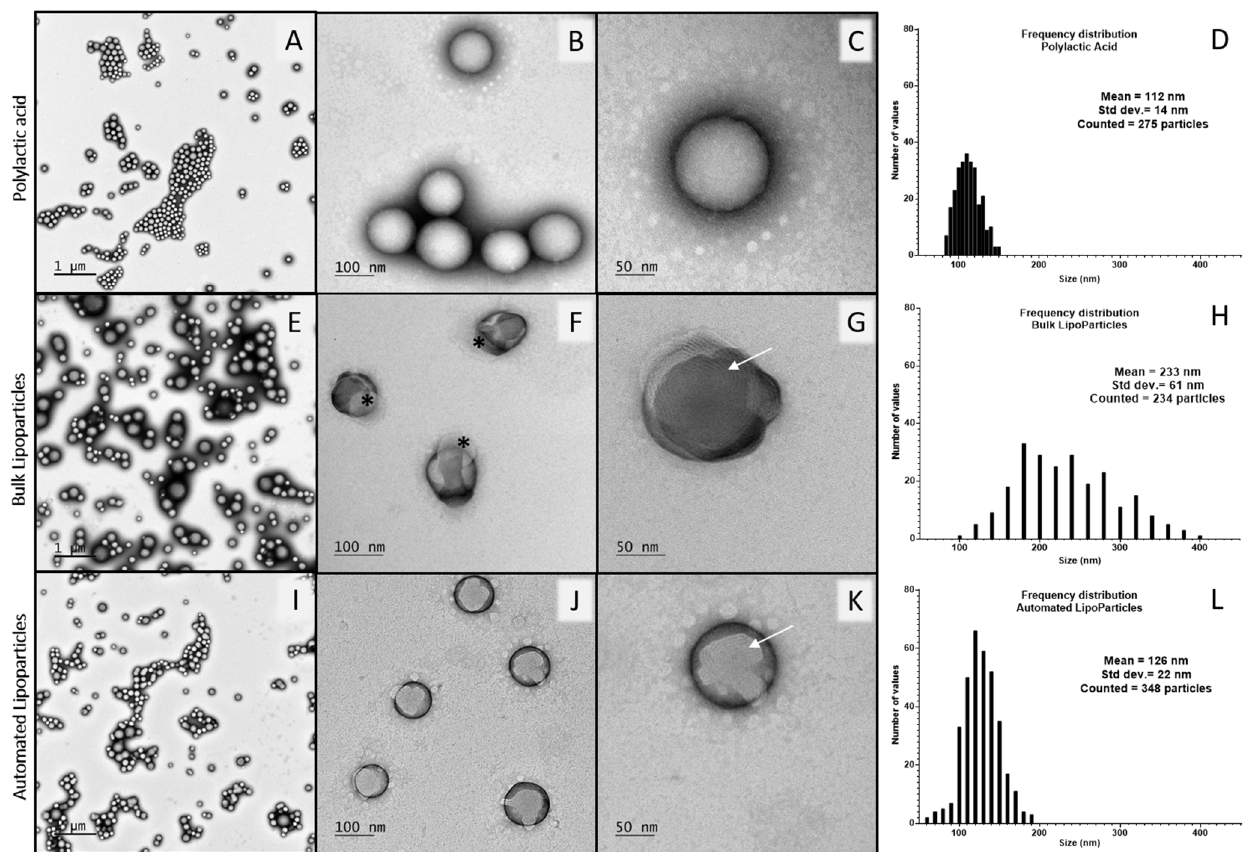
Figure 2. TEM images of PLA-NP ( A – C ), LP ( E – G ), and LP auto ( I – K ) stained with 1% ( w / v in water) tungsten silicate solution. White arrows indicate lipid layers on LipoParticles ( G , K ), while black asterisks indicate eccentric lipid vesicles attached to LP ( F ). Size particle analysis was performed on 1 µm scaled images to evaluate the size distribution frequency of nanoparticles (graphs D , H , L ). Scale bars are indicated on each micrograph. Table 2. Validation methods for DSPC and DOTAP quantification by HPLC–MS. The table presents intra-day and inter-day precision and